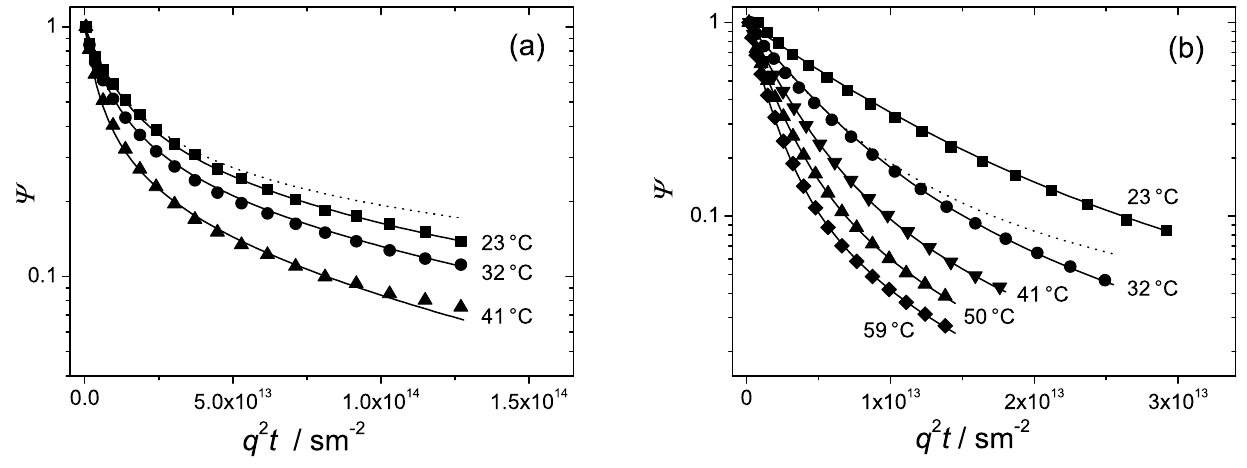
/D /D will use that of the parameters, D or D , which will have the bigger value. ⊥ ⊥ (cid:107) (cid:107) Figure 8. The normalized spin echo diffusion attenuations of the triblock copolymer P123 in water at different temperatures in the ( a ) hexagonal phase, c = 0 . 5 and ( b ) lamellar phase, c = 0 . 7 . Solid curves are fits of Equation (6) to the data points. The dashed curves are fits of the ( a ) Equation (7) in the “one-dimensional” limit and ( b ) Equation (8) in the “two-dimensional” limit.